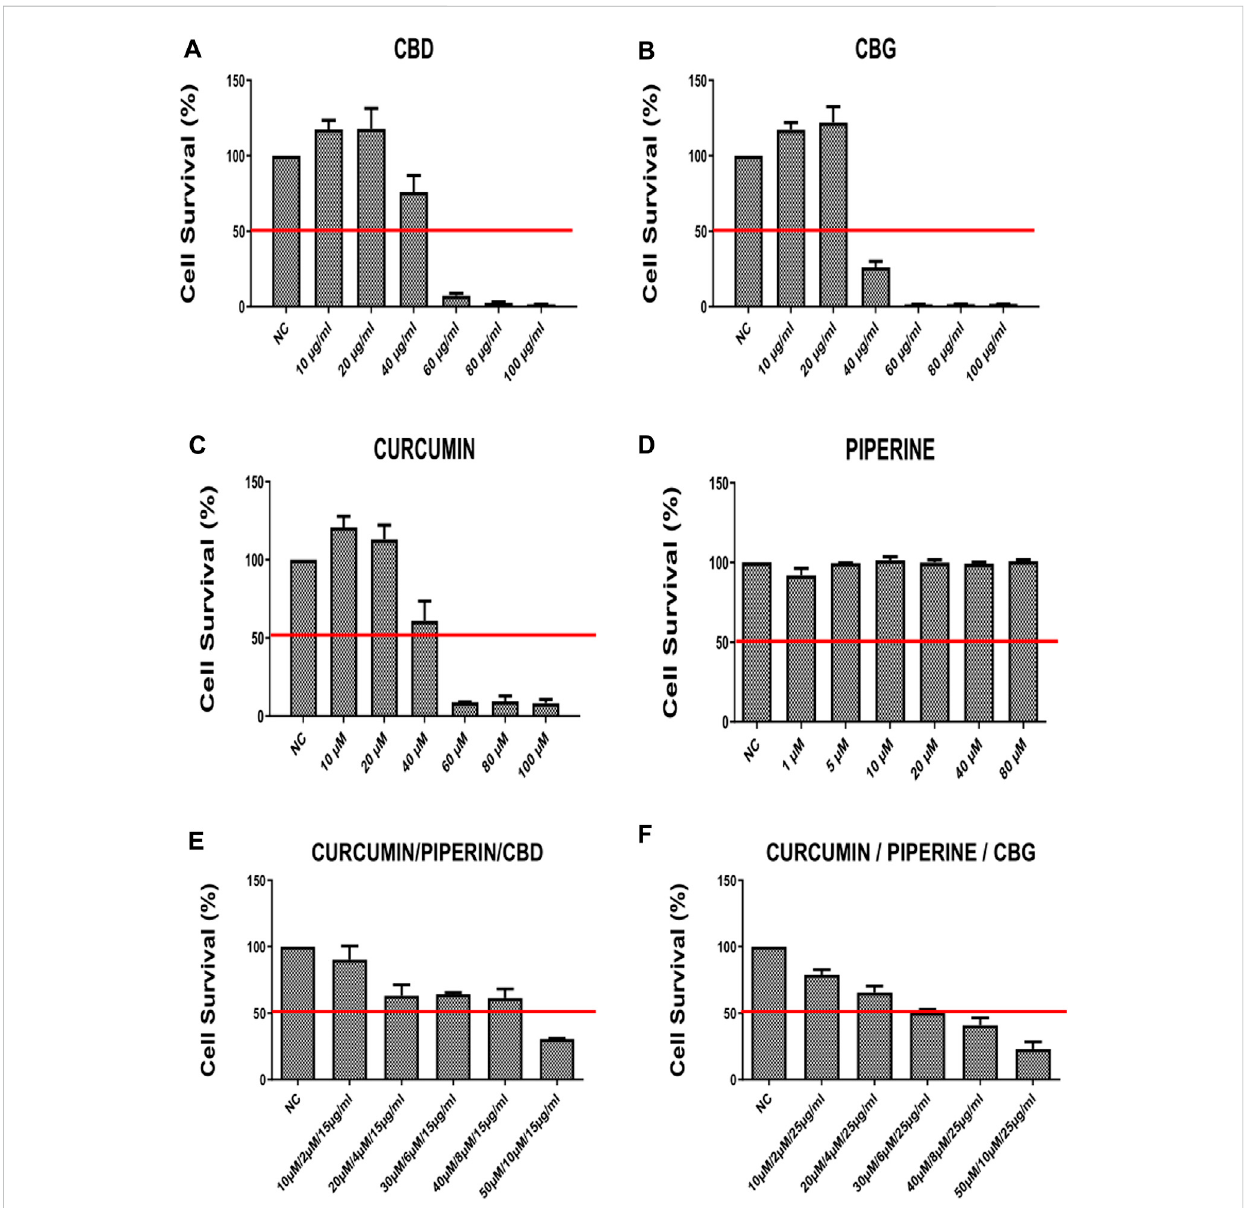
FIGURE 1 Thecellsurvivalrates(percent)ofHCT-116lineat72 haftertreatmentwith (A) CBD(Cannabidiol) (B) CBD(Cannabigerol) (C) Curcumin (D) Piperline (E) combination of curcumin piperline and CBD (F) combination of curcumin piperline CBG. All groups were compared to their corresponding negative